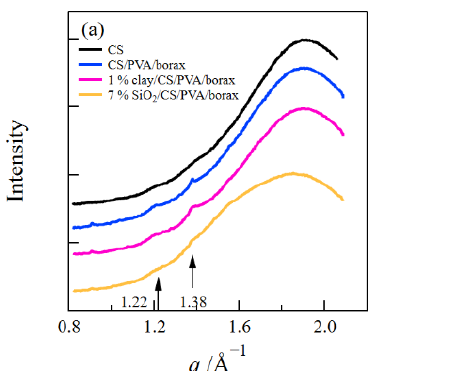
Figure 6. WAXS profiles of 10 wt% CS aqueous solution and CS/PVA/borax, 1 wt% clay/CS/PVA/bo- rax, and 7 wt% SiO 2 /CS/PVA/borax composite hydrogels ( a ), and WAXS profiles of CNF/CS/PVA/borax composite hydrogels at different CNF concentrations ( b ).